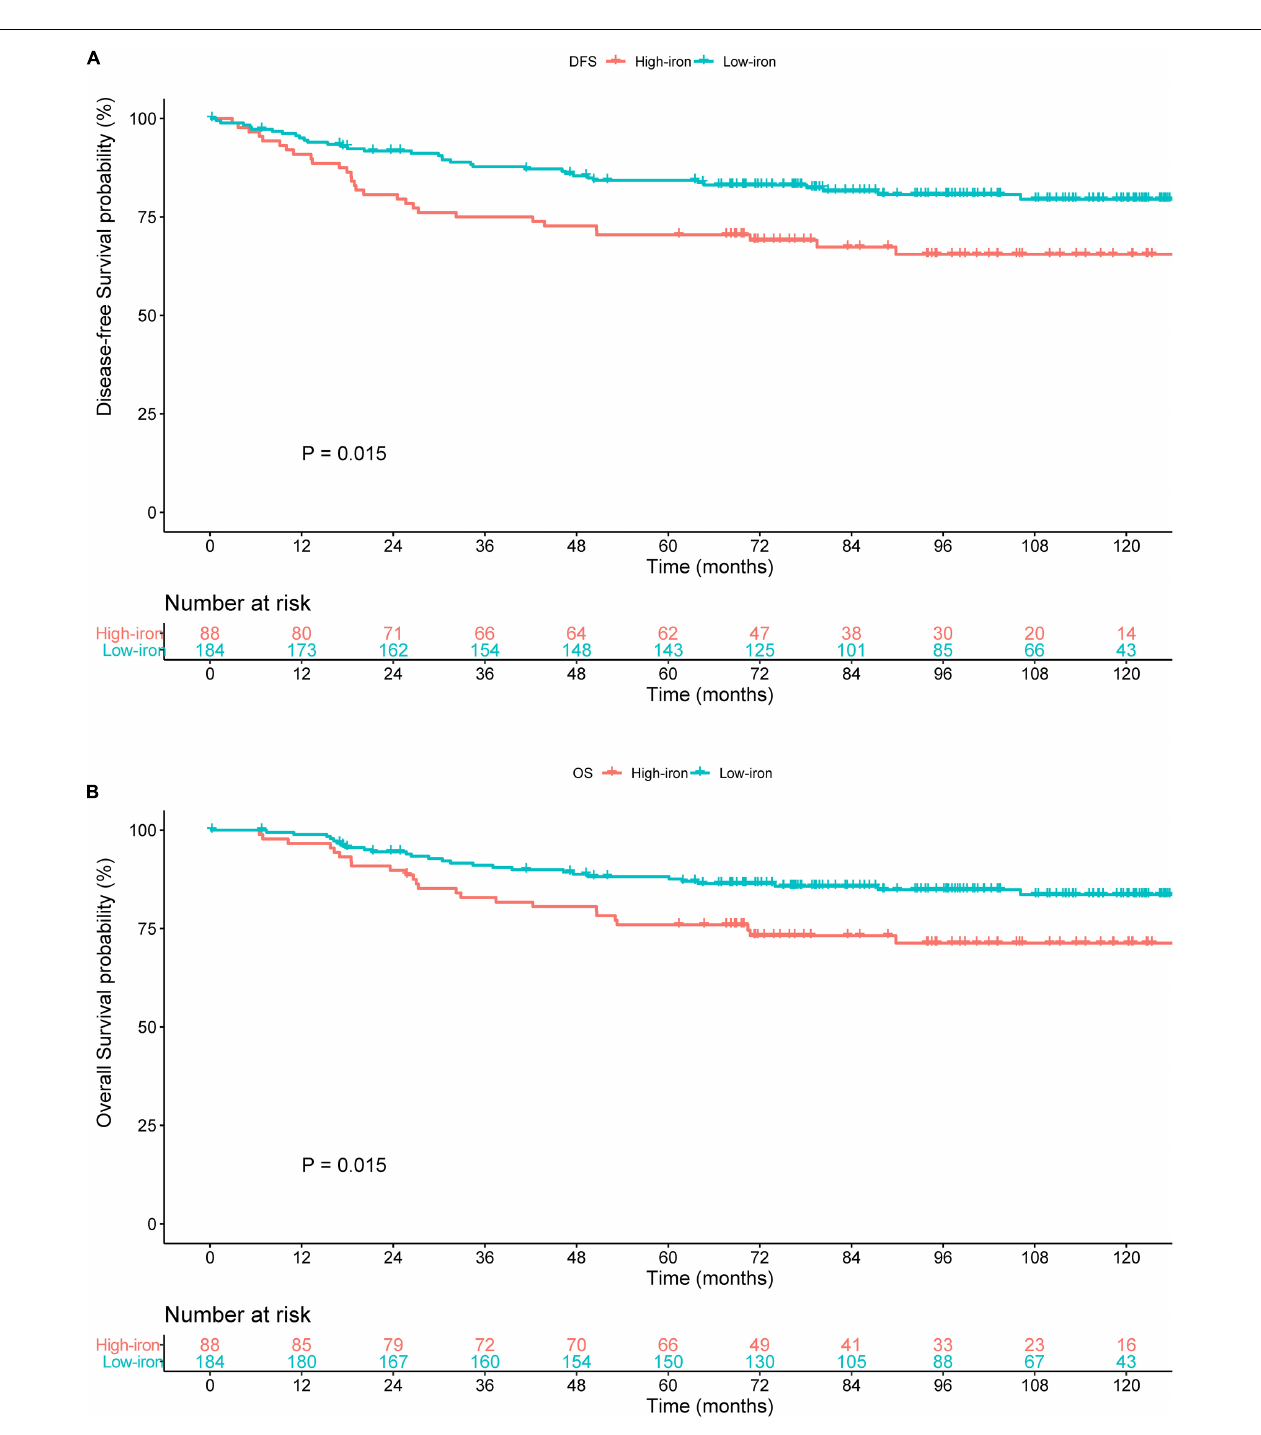
FIGURE 2 | Survival curves estimated by the Kaplan–Meier method and compared with log-rank tests in different groups of serum iron level in the training cohort. (A) Disease-free survival (DFS) curve. (B) Overall survival (OS) curve. Low iron: ≤ 17.84 µ mol/L; high iron: > 17.84 µ mol/L.